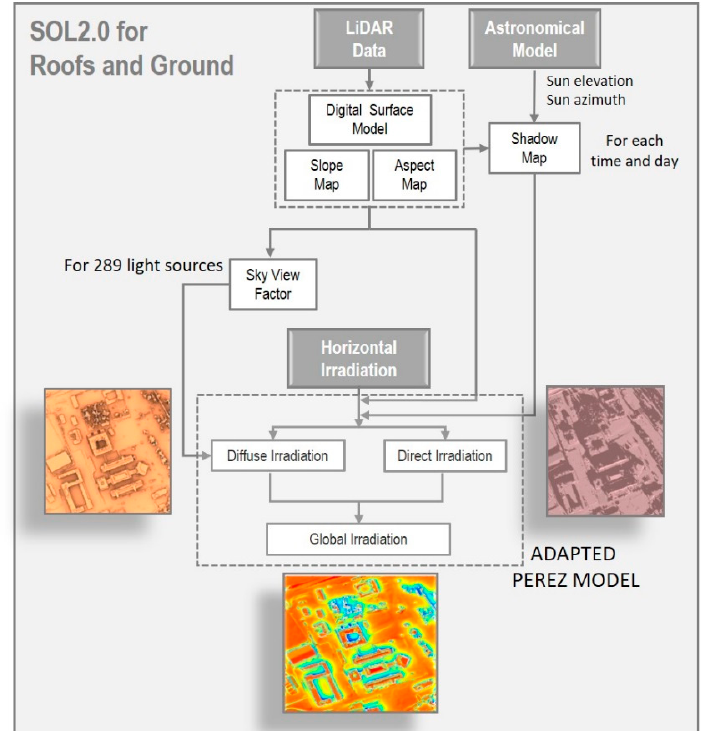
Figure 3. SOL 2.0 workflow for roofs and ground.